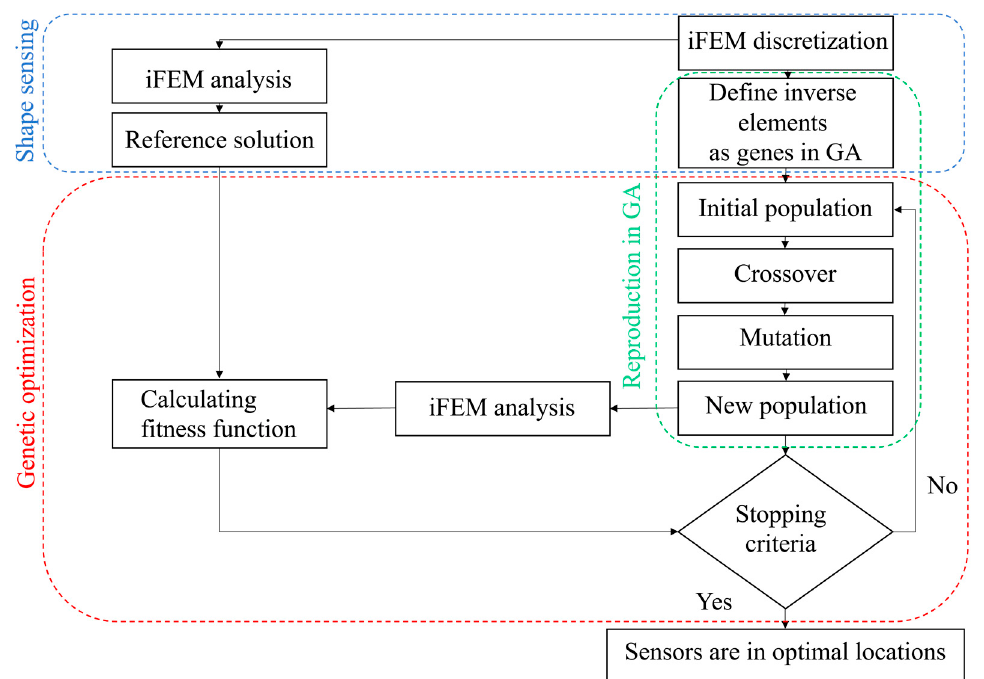
Figure 3. Optimizing the sensor placement using genetic algorithm.